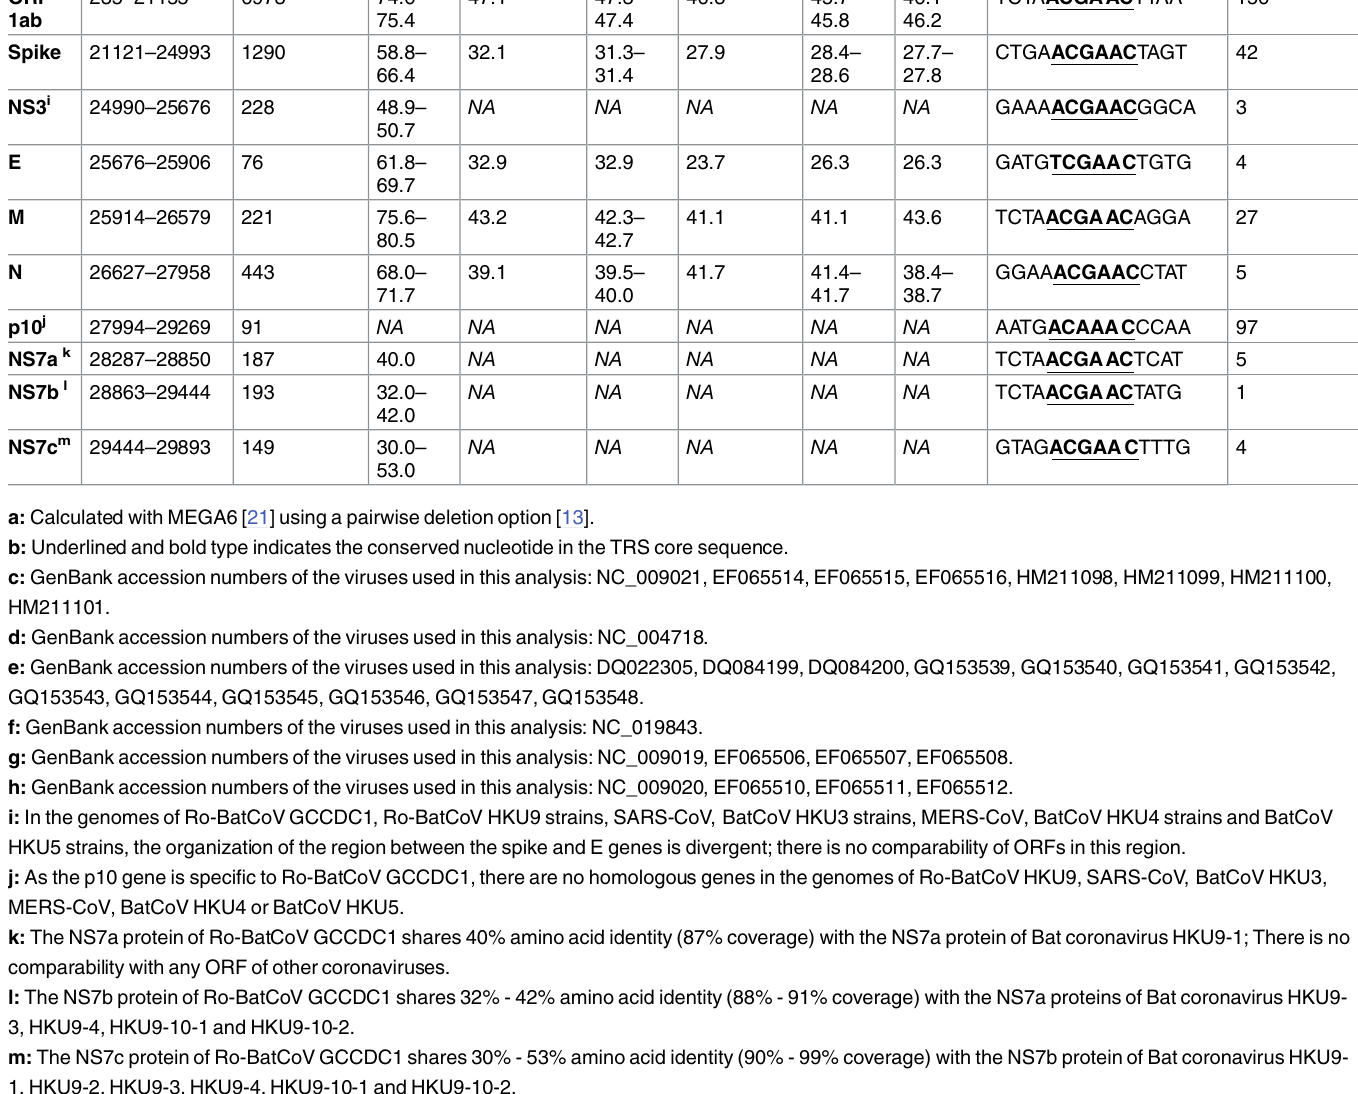
Table 1. Codingpotential,transcription regulatorysequencesand sequence comparisons of Ro-BatCoVGCCDC1 withRo-BatCoVHKU9 strains, SARS-CoV, BatCoVHKU3 stains,MERS-CoV, BatCoVHKU4 strainsand BatCoVHKU5 strains. ORFs Nucleotide